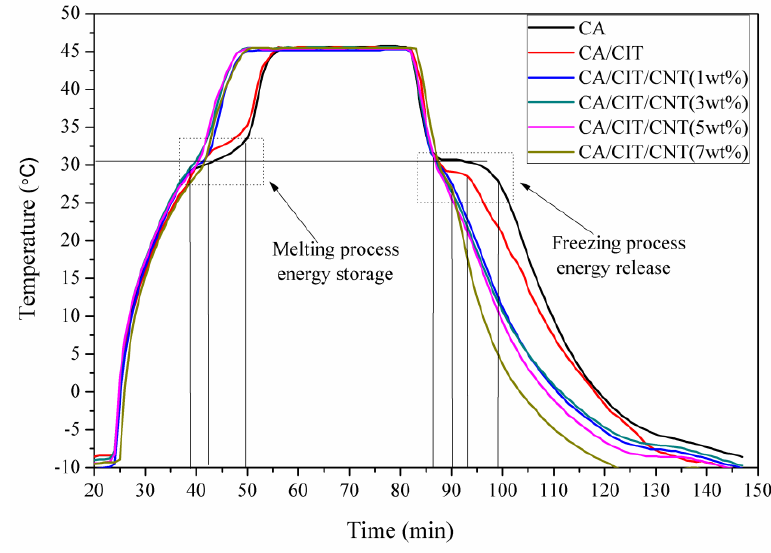
/ CIT FSPCM, and CA / CIT / CNT